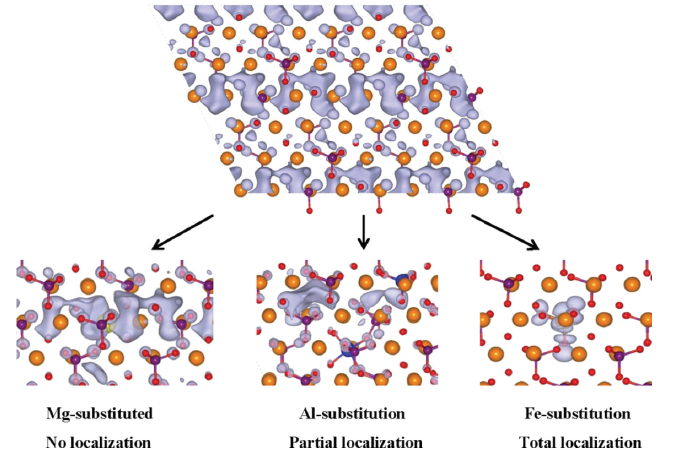
Figure 3. VBM distribution on pure alite unit cell and details of the localization for Mg, Al and Fe chemical substitutions. Atomic color codes are oxygen: red, calcium: orange, silicon: purple, magnesium: yellow, aluminum: blue [44]. Copyright 2011 American Chemical Society.